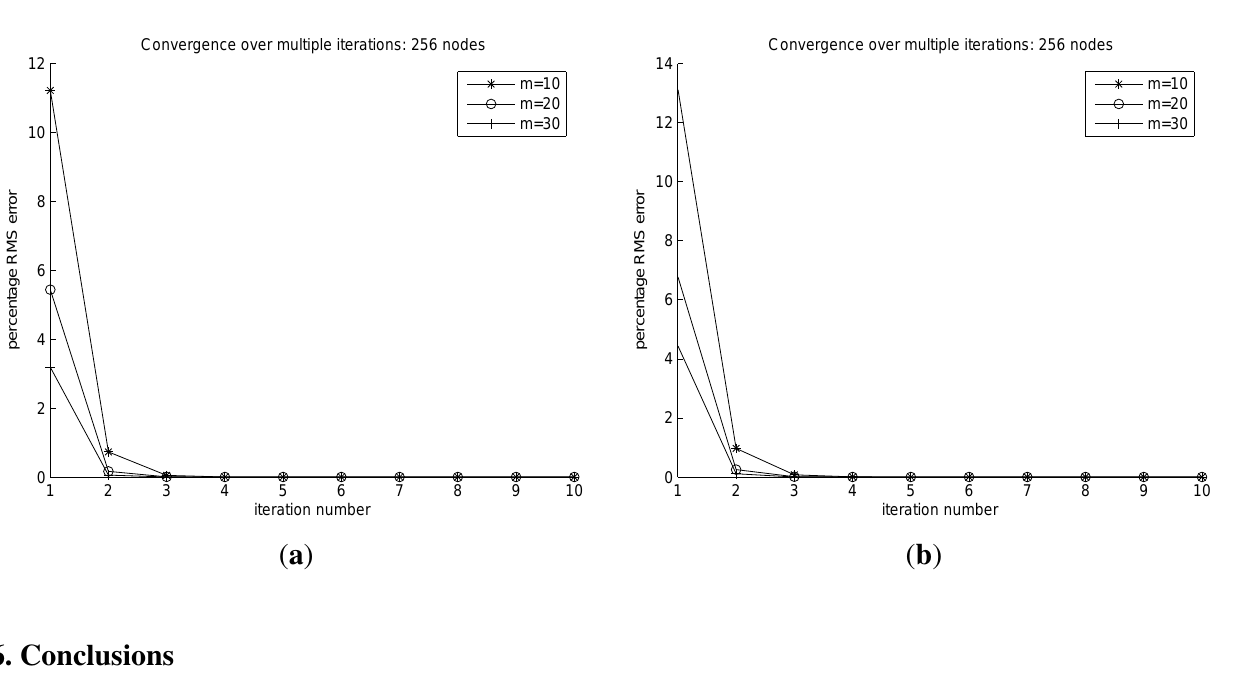
Figure 6. ( a ) Convergence as a function of the control distance in a 256 node network; ( b ) convergence as a function of the control distance in a 1 , 024 node